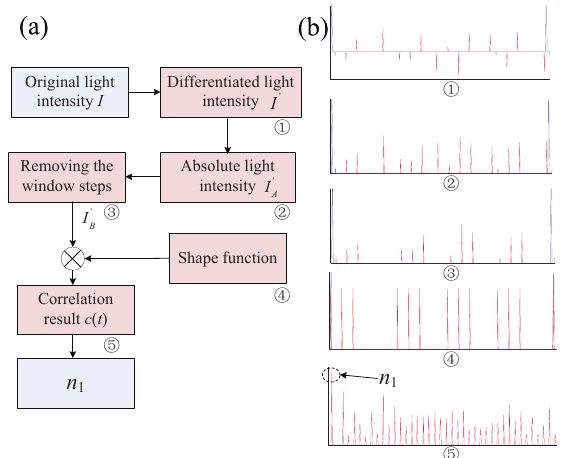
Figure 3. The automatic time window locating method. ( a ) the implementation procedure; ( b ) the temporal implementation result example.